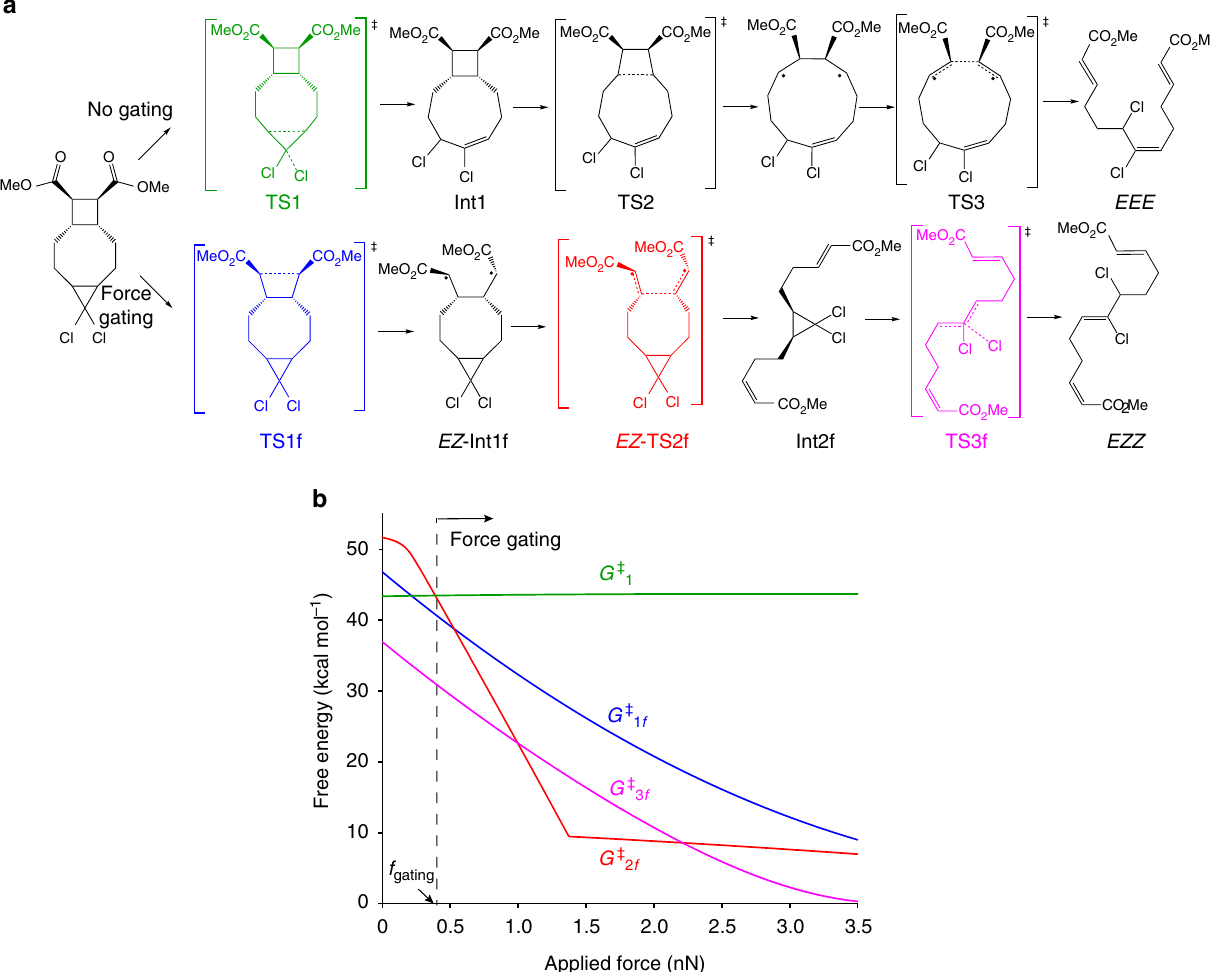
Figure 2 | The computed effects of force on the reaction mechanism and activation barriers. ( a ) The minimum-energy reaction mechanisms without and with gating are different as are the final products. The relative contributions of the EE and EZ conformers of Int1f and TS2f vary with force (Supplementary Fig. 2): for clarity only one set of isomers is shown. ( b ) Calculated heights of the free energy barriers (see text for assumptions and details of theoretical methods) in methylbenzoate as a function of the applied force calculated as the differences of the free energies of (i) TS1 and TS1f relative to 5,5-dichlorotricyclo(7.2.0.0)undecane (DCTCU) ( G 1 z and G 1 f z , respectively), and (ii) TS3f relative to Int2f ( G 3 f z ); G 2 f z is the free energy of TS2f relative to (i) DCTCU up to 1.4nN and (ii) Int1f at 4 1.4nN, when Int1f becomes lower in energy than DCTCU. The calculated cross-over between the non-gated and gated reactivity, f gating , occurs at B 0.45nN as